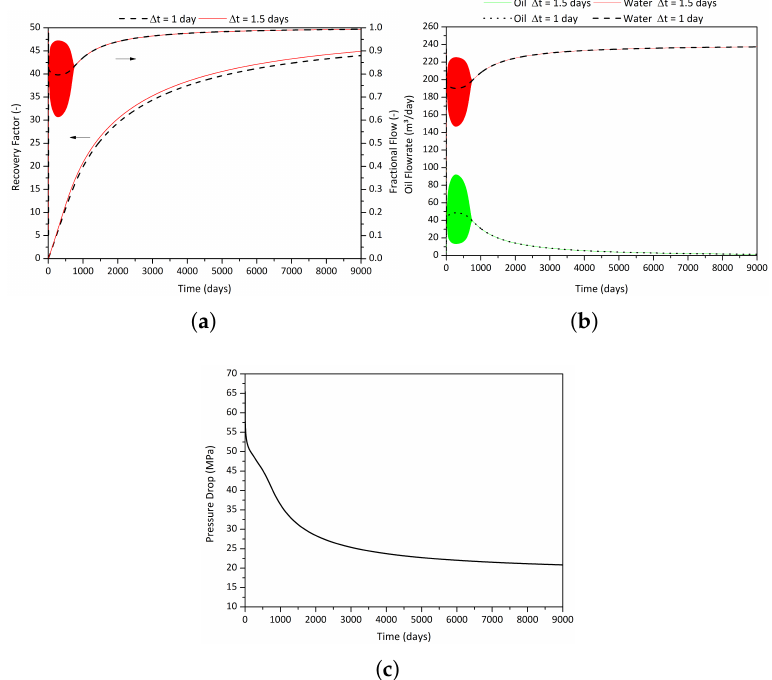
Figure 9. Cumulative oil production and fractional flow ( a ), oleous and aqueous produced flowrates ( b ), and pressure drop ( c ) for a non-iterative secondary recovery